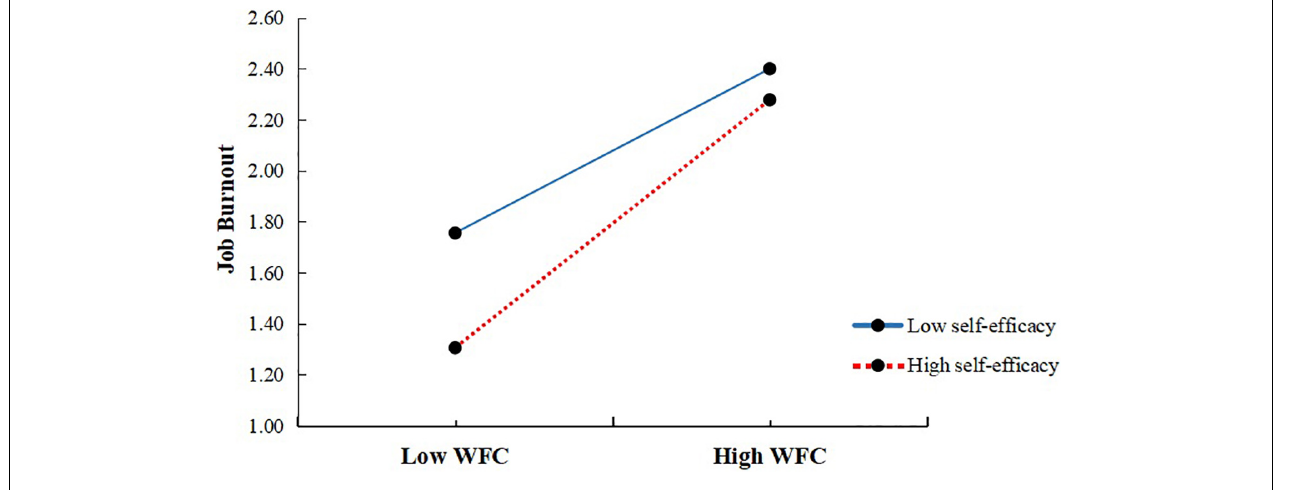
FIGURE 2 | Interaction between work–family conflict and self-efficacy on job